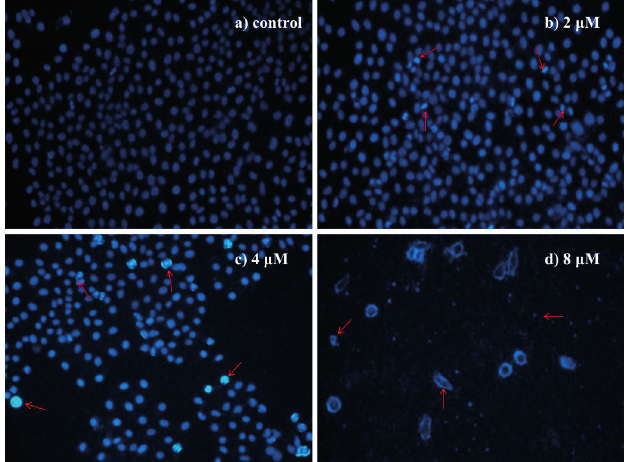
Figure 3. Morphological observation of HepG2 cells using DAPI staining (200×): ( a ) control group; ( b ) 2 μ M; ( c ) 4 μ M; and ( d ) 8 μ M. The cell morphology was observed under the fluorescence microscope after DAPI staining. The most representative fields are shown. Arrows indicate the typical apoptotic